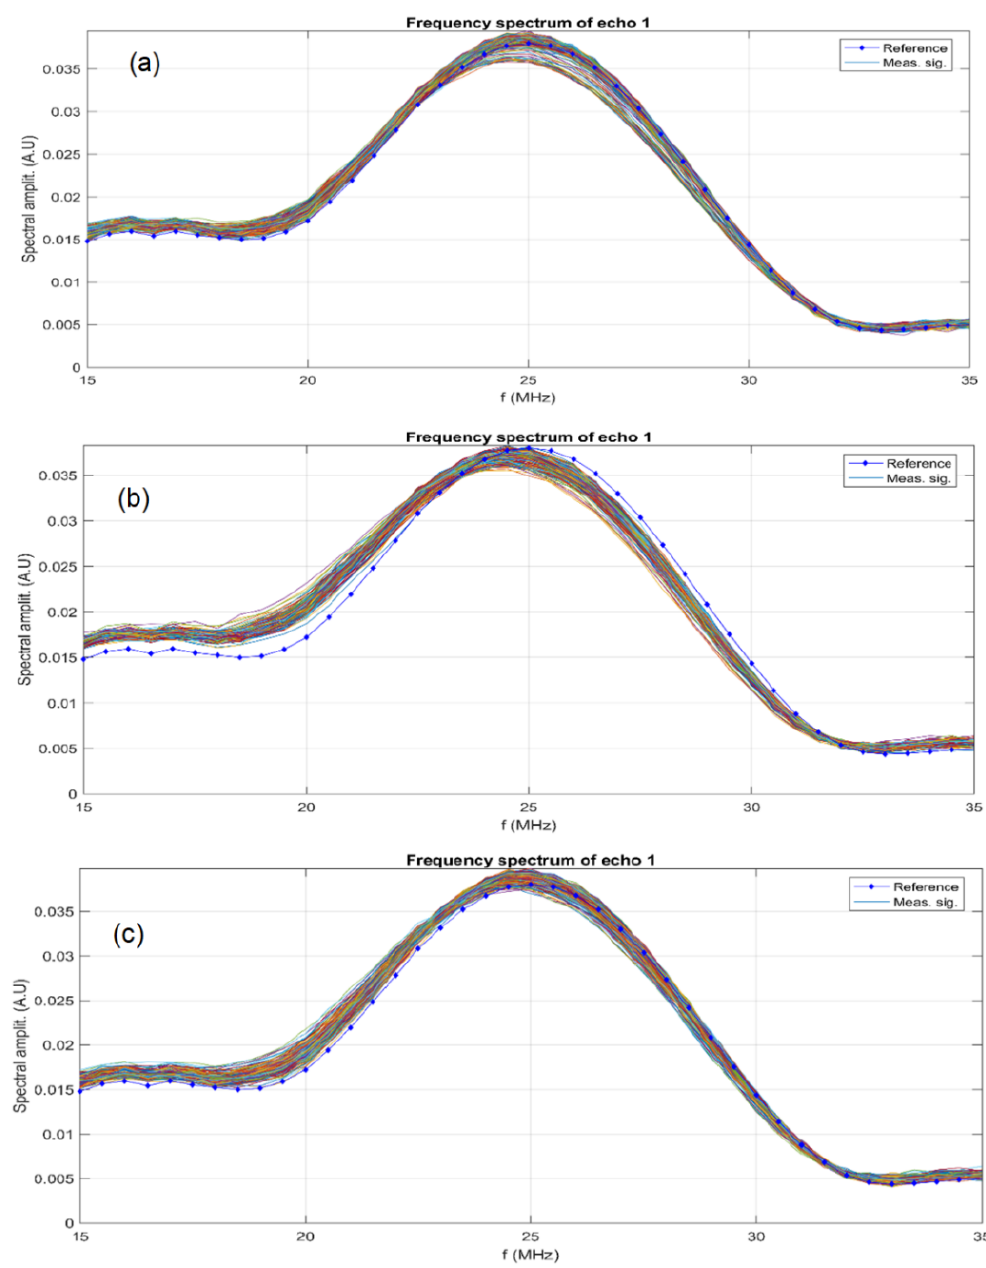
Figure 5. Frequency spectra of all recorded signals and of the reference liquid AgHA ( a ), AgHA-C ( b ) and AgHA-T ( c ) samples from top to bottom.